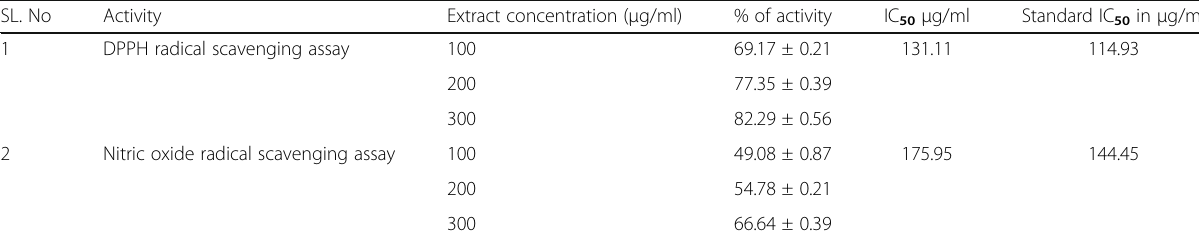
Table 2 In vitro antioxidant assay of GFME SL. No